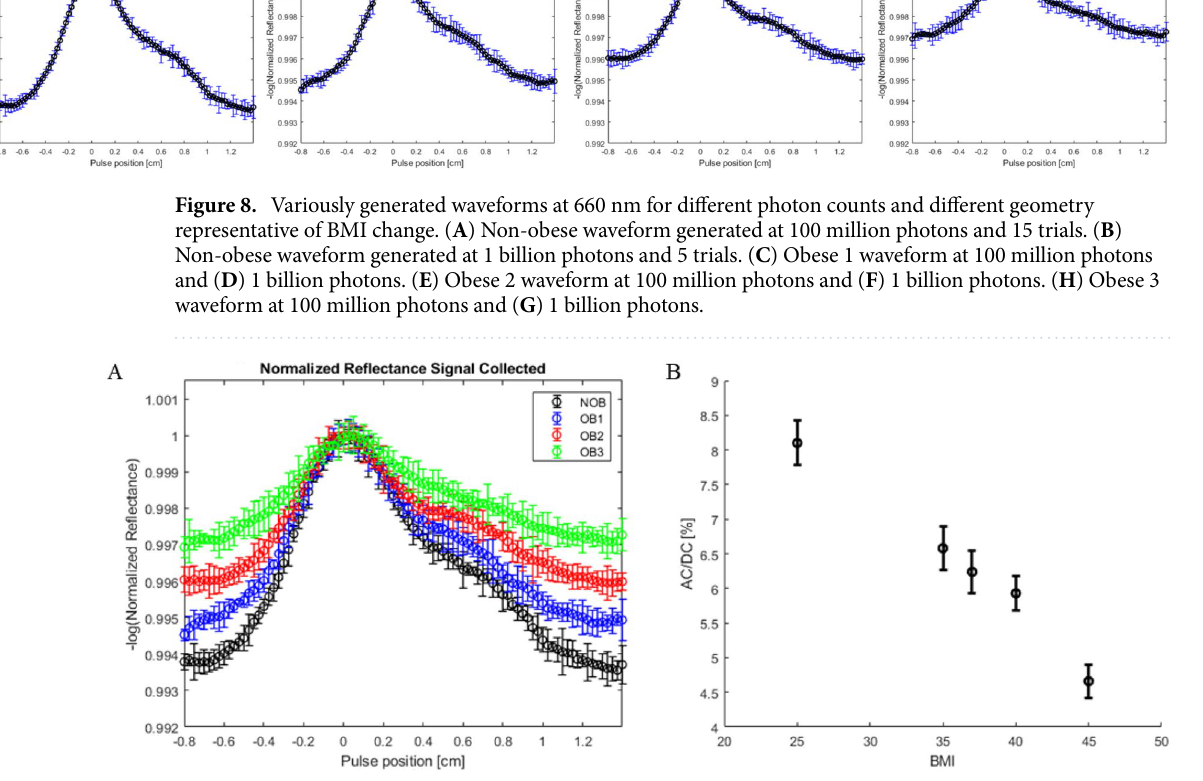
Figure 9. ( A ) Superposition of four different waveforms at 1 billion photons. Black: Non-Obese. Blue: Obese 1. Red: Obese 2. Green: Obese 3. ( B ) AC/DC ratio for each waveform signal comparison.